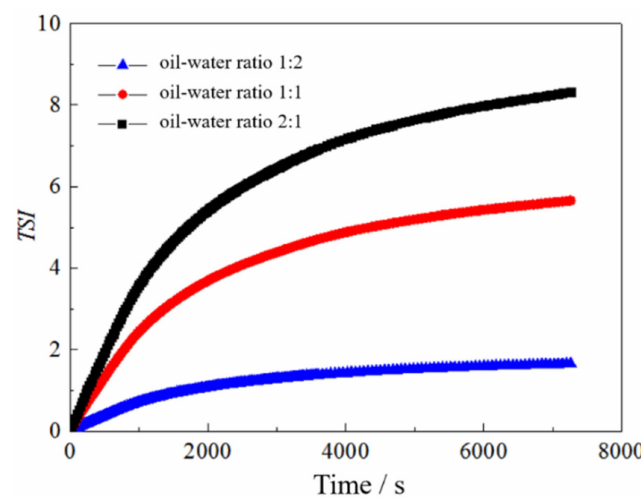
Figure 16. Relationship between TSI and the oil–water